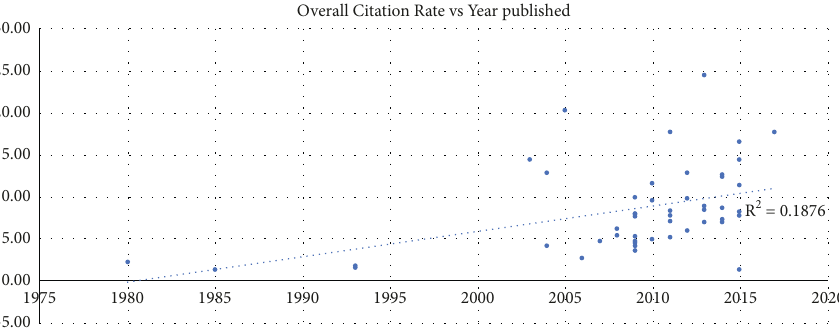
Figure 2: Overall citation density vs year published.